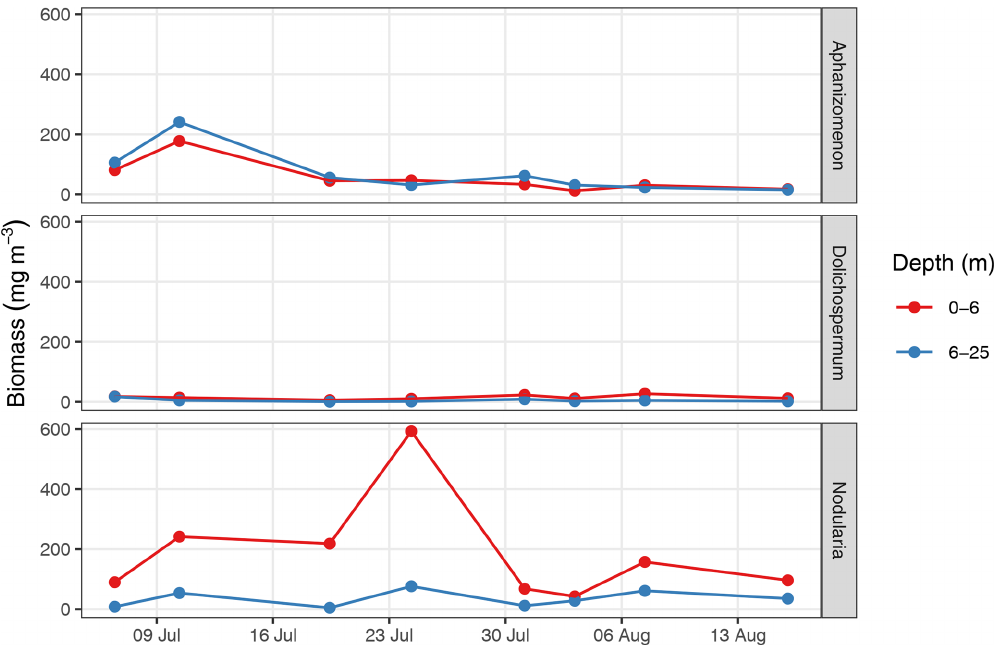
Figure B2. Time series of cyanobacterial biomass, averaged for surface (0–6m) and subsurface (6–25m) water masses sampled from stations 07 and 10 (Fig. 1). Results are based on microscope counts and distinguish three genera